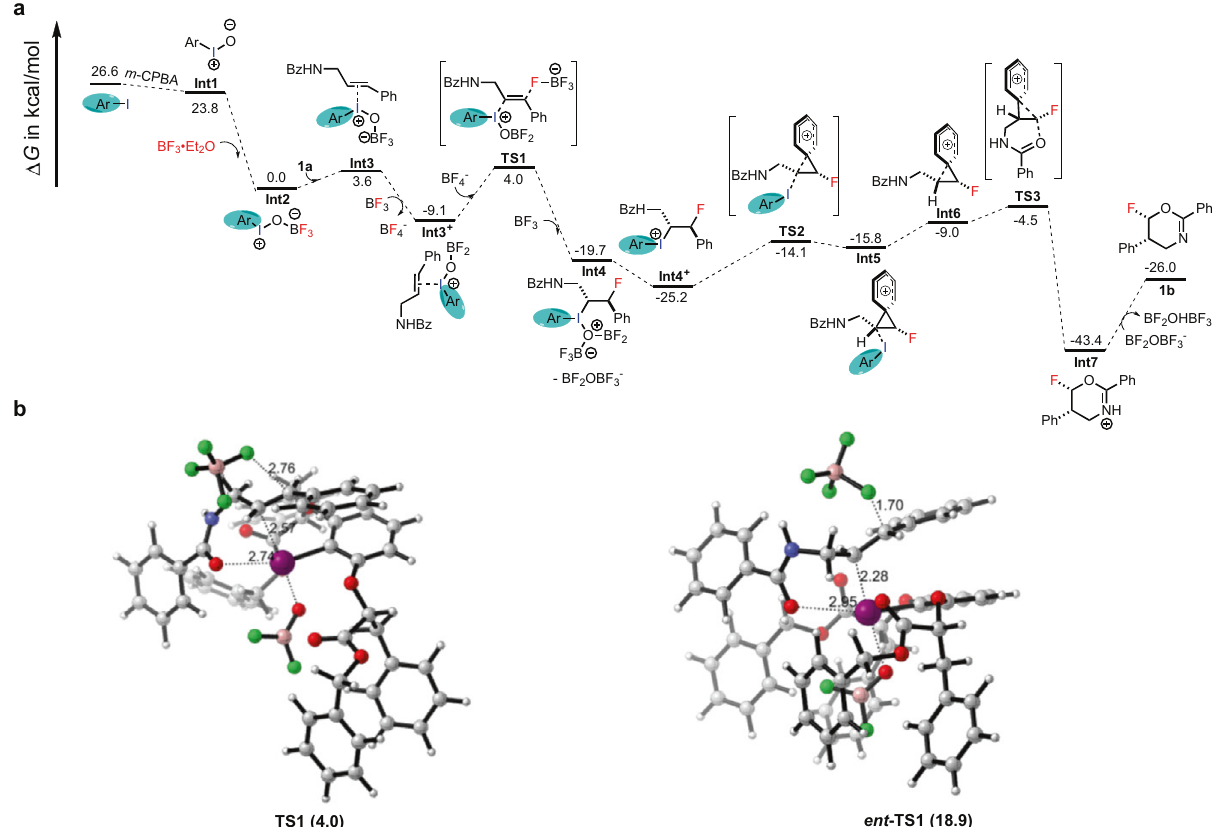
Fig. 6 Calculated energy pro fi le and DFT calculations for enantioselectivity of the catalytic asymmetric fl uorination. a DFT-computed reaction pro fi le for the catalytic asymmetric fl uorination of 1a and BF 3 ·Et 2 O in the presence of CIC1 and m -CPBA. b DFT-optimized stereo-determining transition state ( TS1 ) structures and their relative energies for Int2